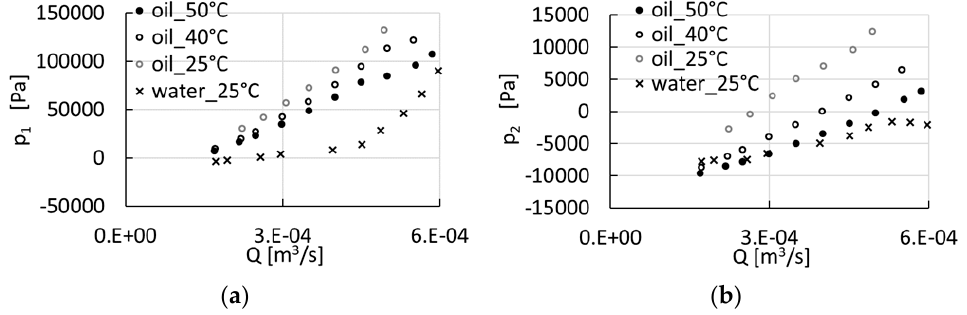
Figure 5. ( a ) Dependence of relative inlet pressure p 1 (Pa) vs. volume flow rate Q (m 3 · s − 1 ); ( b ) Dependence of relative outlet pressure p 2 (Pa) vs. volume flow rate Q (m 3 · s − 1 ).